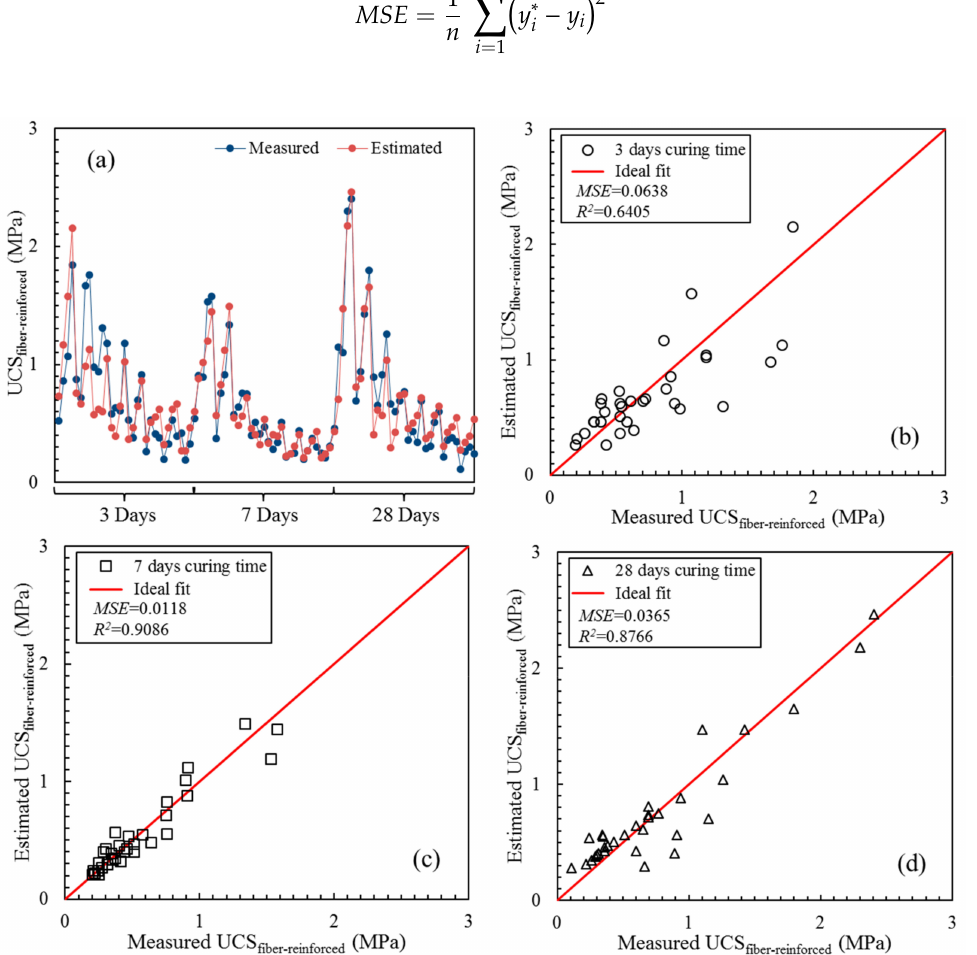
Figure 8. Estimated value of UCS fiber-reinforced and its regression as a function of the measured values with di ff erent curing times: ( a ) measured values and estimated values; ( b ) 3 days curing time; ( c ) 7 days curing time; ( d ) 28 days curing